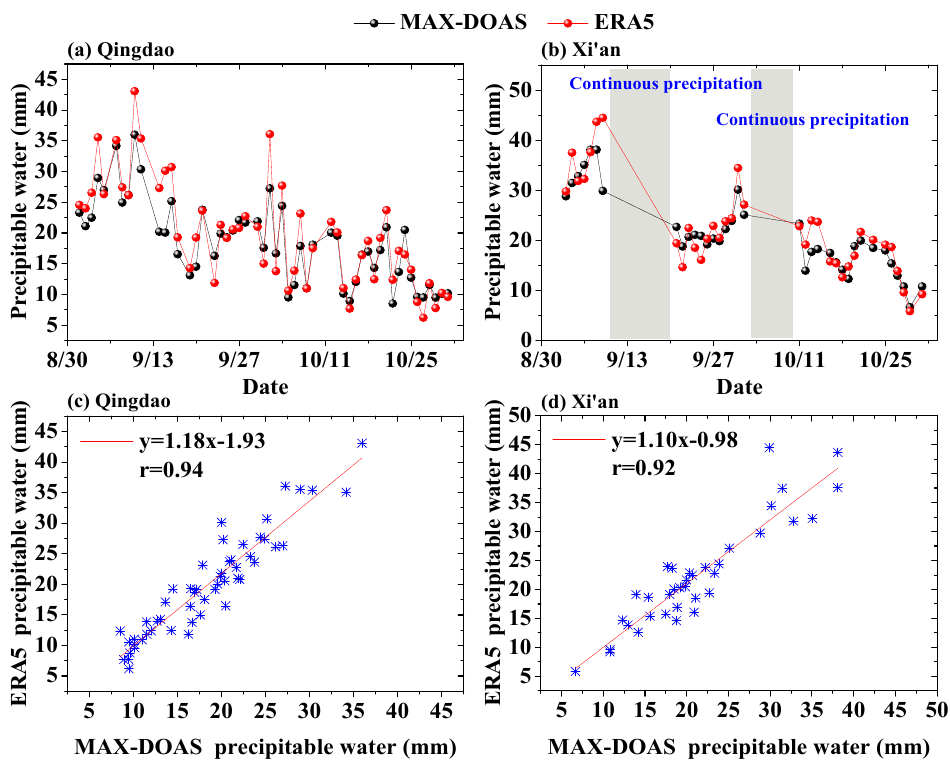
Figure 5. Comparison of MAX-DOAS measurements and ERA5 reanalysis datasets for precipitable water (PW): ( a ) time series of the PW in Qingdao; ( b ) time series of the PW in Xi’an; ( c ) correlation analysis of the PW in Qingdao; ( d ) correlation analysis of the PW in Xi’an.